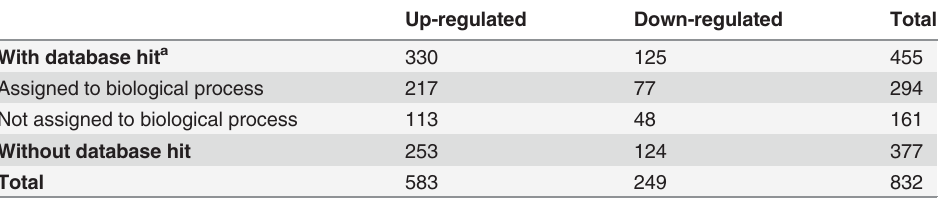
Table 2. Differentially expressed transcripts resulting from the MACE and DEGseq analyses, filtered by log 2 fold change and minimum different sense tags ( (cid:1)